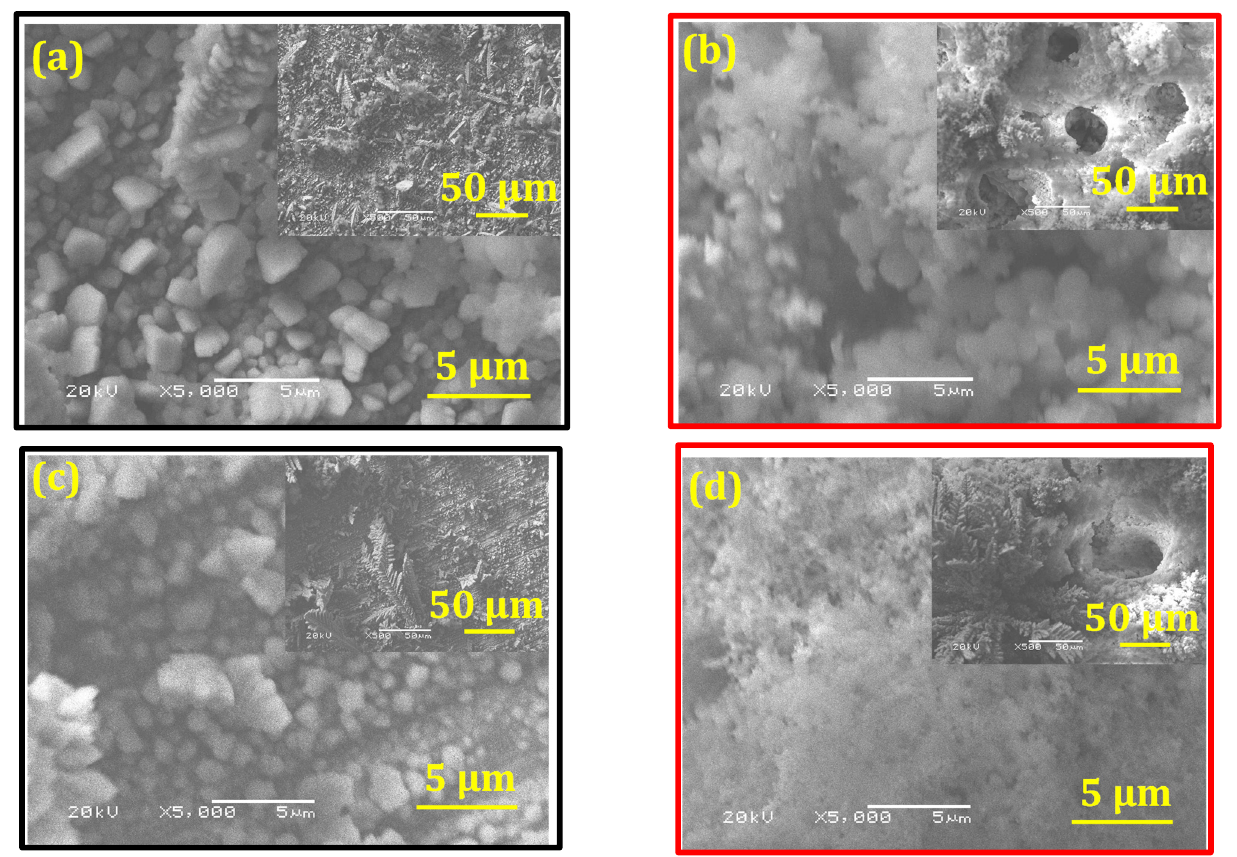
Figure 3. SEM micrographs of Zn–Mn alloy coatings electrodeposited as a function of magnetic field amplitudes: B = 0 T ( a ) E = − 1.6 V/SCE and ( b ) E = − 1.8 V/SCE, B = 0.3 T ( c ) E = − 1.6 V/SCE, and ( d ) E = − 1.8 V/SCE.